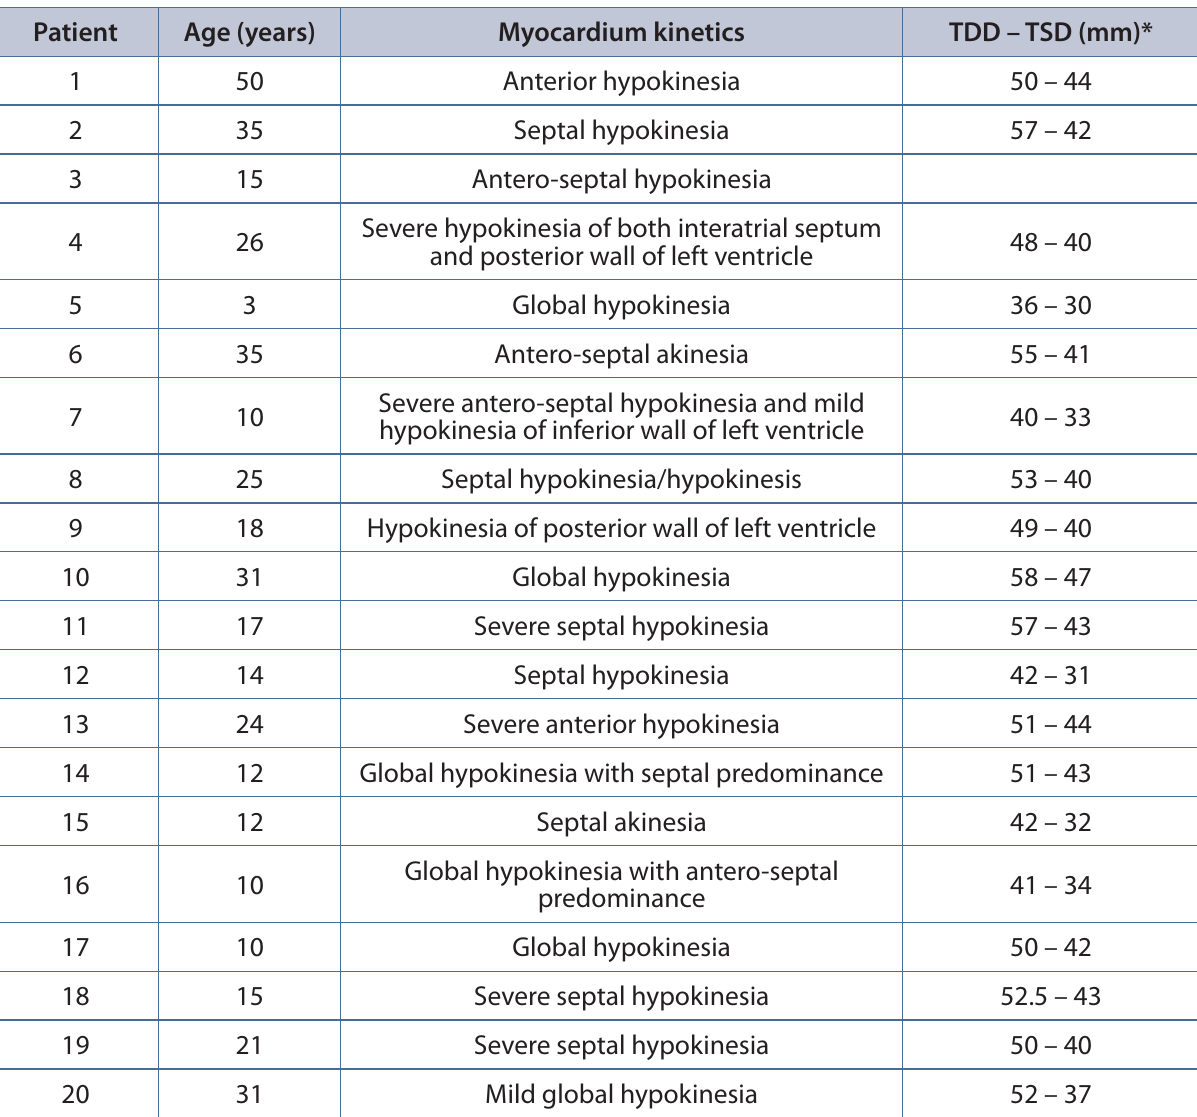
Table 1. Changes in cardiac functions